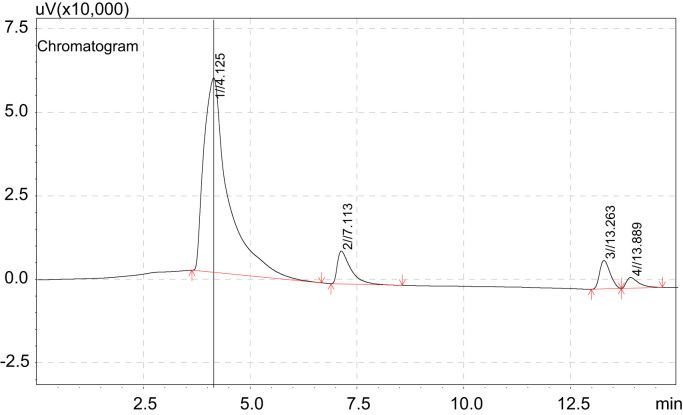
Sample standard.